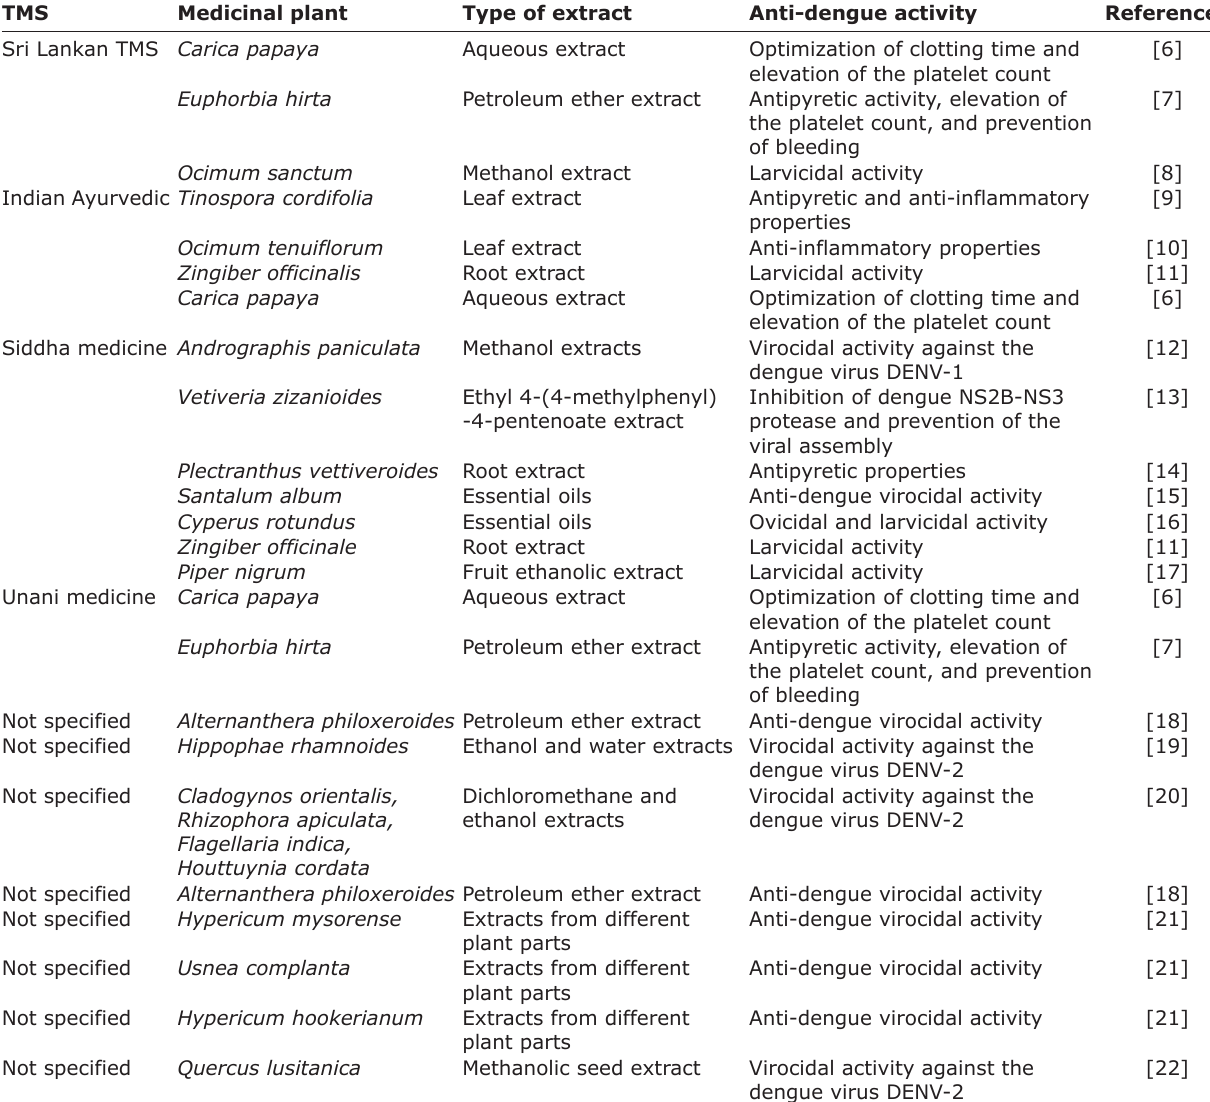
Table-1: Anti-dengue properties of some medicinal plants used in different TMSs.